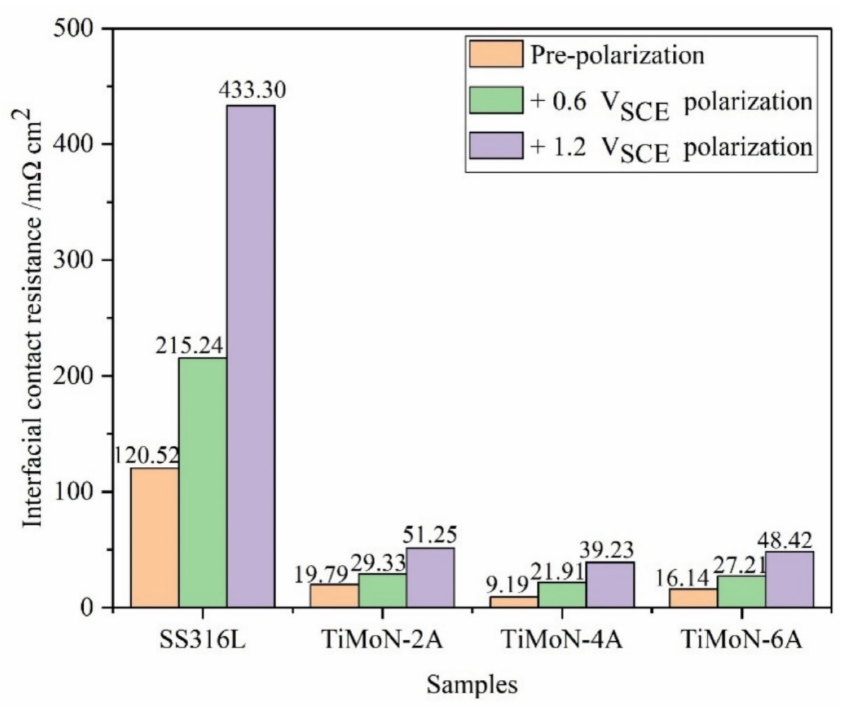
Figure 9. ICR measurement results of SS316L and TiMoN coatings before corrosion, 0.6 V SCE and 1.2 V SCE at high potential under simulated PEMFC cathode